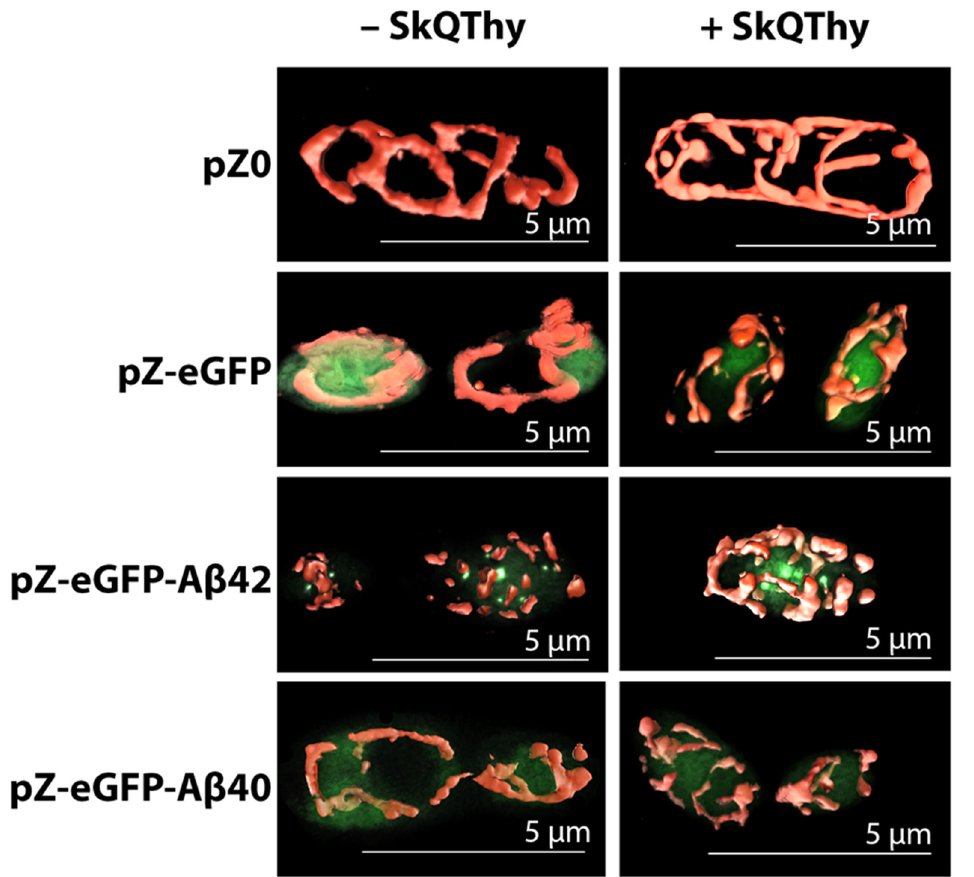
Figure 2. Structure of mitochondria in the Y. lipolytica mutants. Effect of SkQThy. A β 42 aggregates were visualized with eGFP intrinsic fluorescence (shown in green). Cells were preincubated without ( left panel ) or with 250 nM SkQThy ( right panel ) for 1 h and stained with 500 nM MitoTracker Red for 30 min.